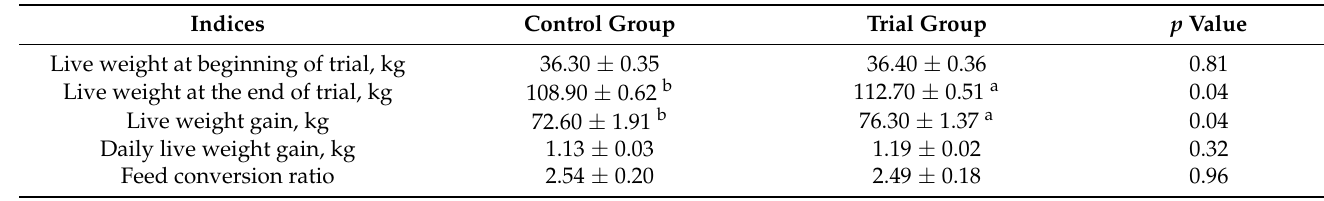
Table 2. Indices of pig growth during 64 trial days.